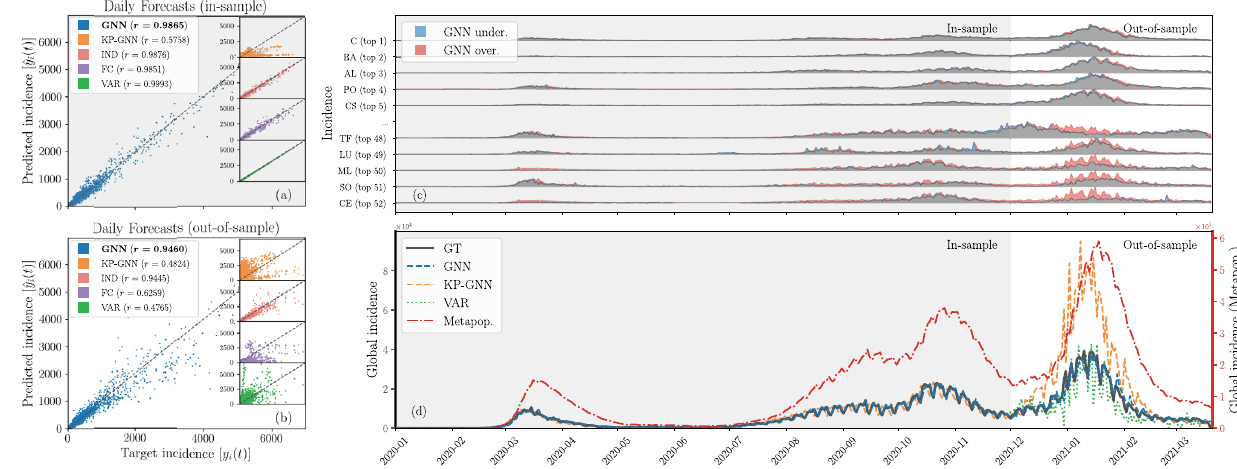
Fig. 5 Learning the Spain COVID-19 dataset. a , b Comparison between the targets and the predictions in the in-sample and the out-of-sample datasets for our GNN model (blue) and for other models (KP-GNN in orange, IND in pink, FC in purple and VAR in green; see main text). The accuracy of the predictions is quanti fi ed by the Pearson correlation coef fi cient provided in the legend. c Forecasts by our GNN model for individual time series of the provincial daily incidence compared with the ground truth. Underestimation and overestimation are respectively shown in blue and red. Each time series has been rescaled as in Fig. 4b and are ordered according to mean square error of the GNN ’ s predictions. d Forecasts for the global incidence (sum of the daily incidence in every province). The solid gray line indicates the ground truth (GT); the dashed blue line, the dashed orange line and dotted green line show the forecast of our GNN model, of KP-GNN and of VAR, respectively. We also show the forecast of an equivalent metapopulation model (red dash- dotted line) which has its own scale (red axis on the right) to improve the visualization; the other lines share the same axis on the left. Similarly to Fig. 4, we differentiate the in-sample from the out-of-sample forecasts using a shaded